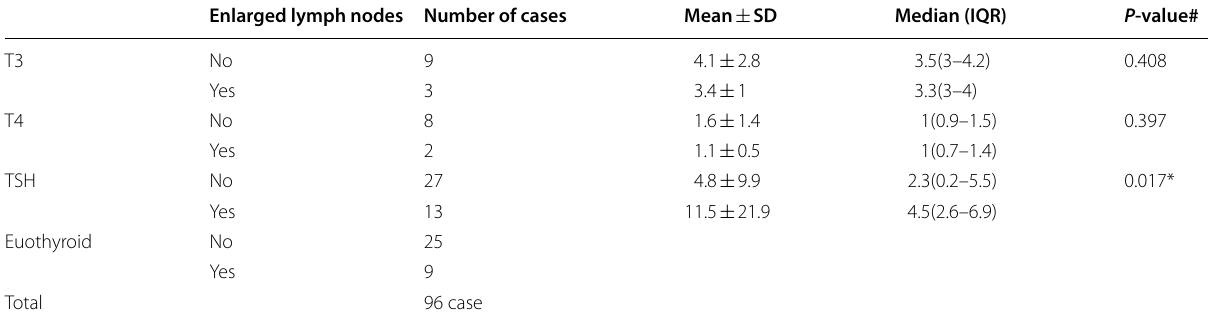
Table 3 Relation between presence of para-tracheal abnormal enlarged lymph nodes and thyroid hormonal level in studied